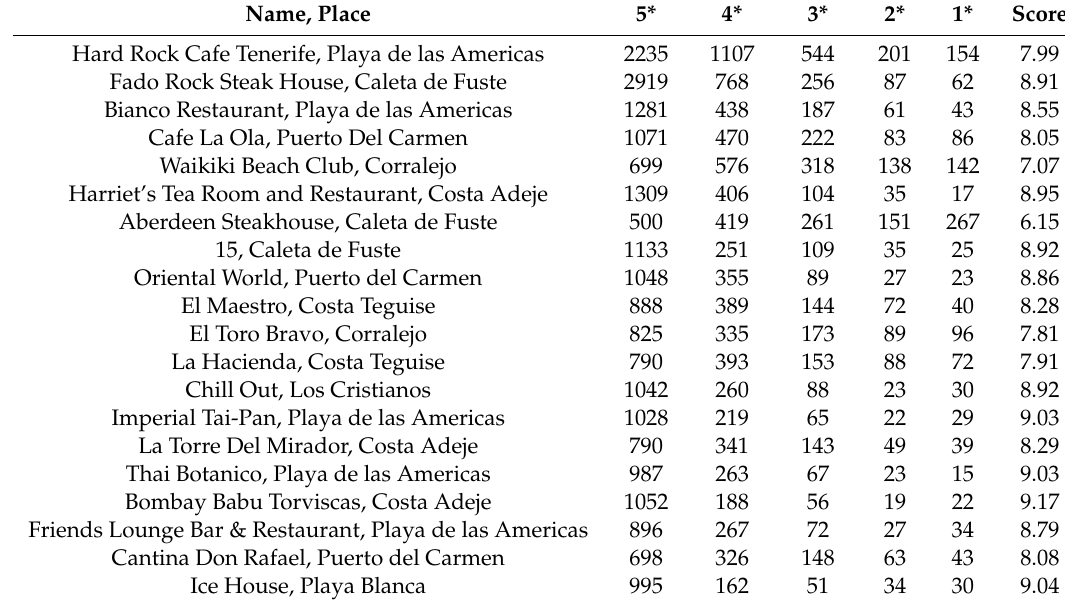
Table 8. Reviewer’s scores for the top 20 Canary Islands establishments serving food. Name, Place